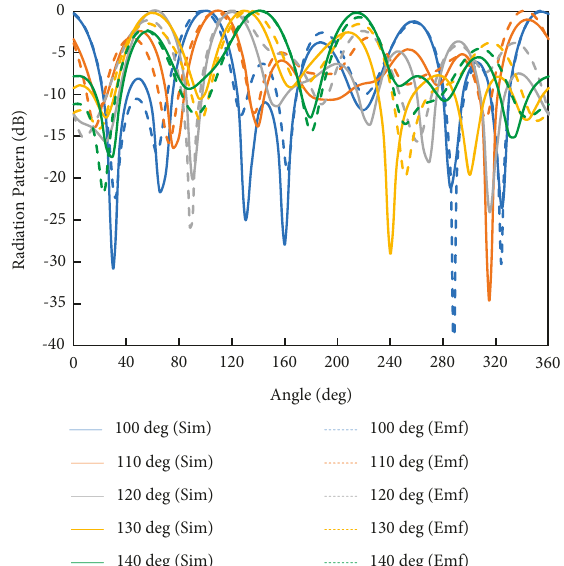
Figure 5: Optimized radiation pattern of 100 ° –140 ° using the induced EMF method and genetic algorithm (solid lines). The results were verified with the full-wave simulation software (dashed lines).